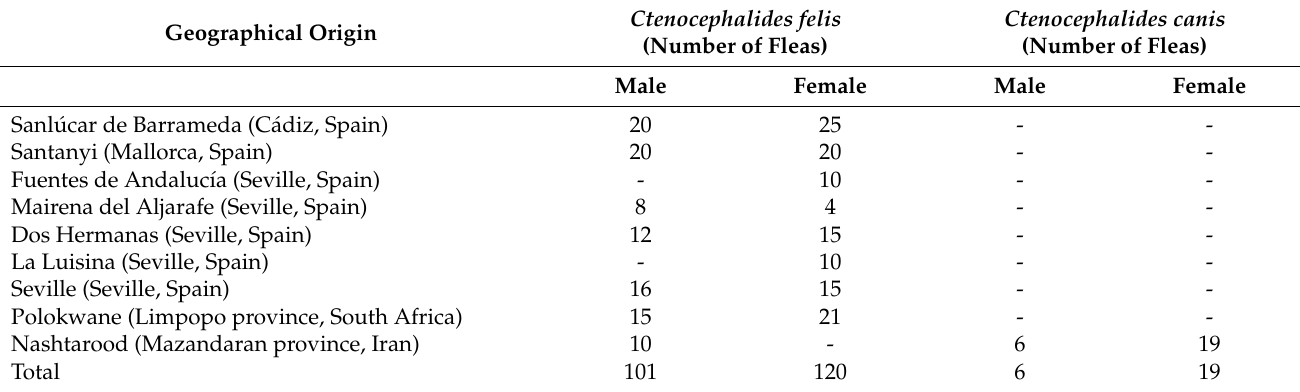
Table 1. Distribution of fleas collected from dogs from different geographical origins. Geographical Origin